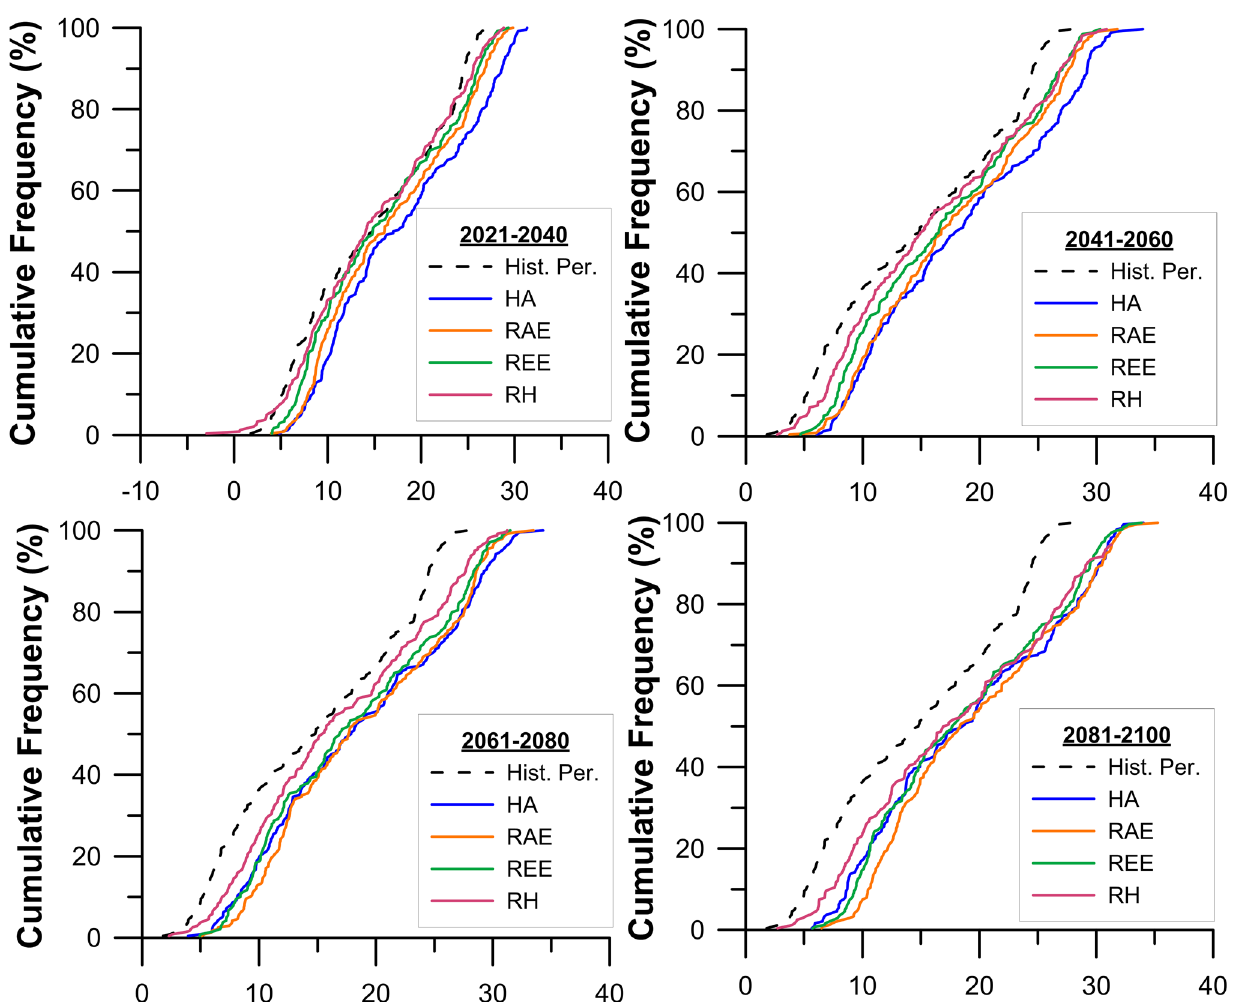
Fig. 11 Cumulative frequency diagrams of average monthly temperature for the historical period (1981–2000) and all RCM–GCM combinations at the four